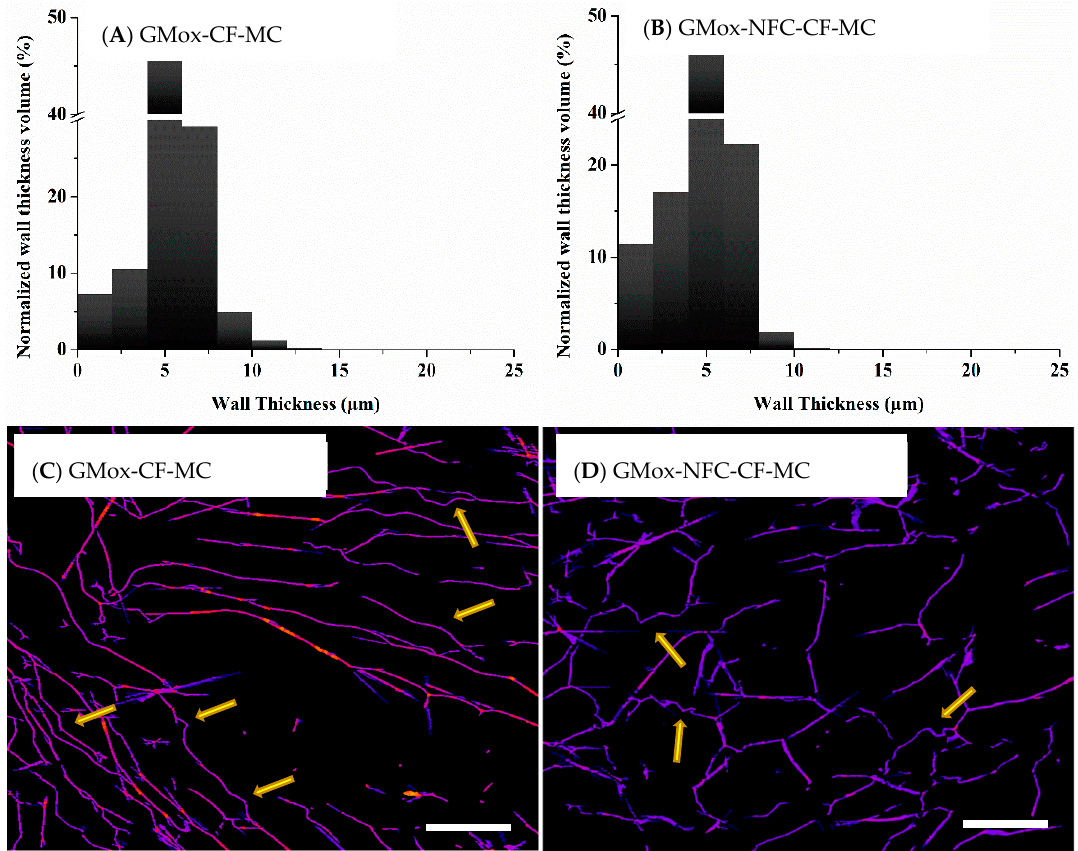
Figure 10. Volume-weighted pore-wall thickness distribution of ( A ) GMox and ( B ) GMox-NFC. Segmented middle slice (s1080/2160) from the local thickness map of ( C ) GMox and ( D ) GMox-NFC for pore-wall thickness distribution. Aerogels were prepared by the conventional freezing (CF) method. MC = mechanically compressed. The scale bar in C and D is 100 μ m. Arrows indicate the observed buckling effect.